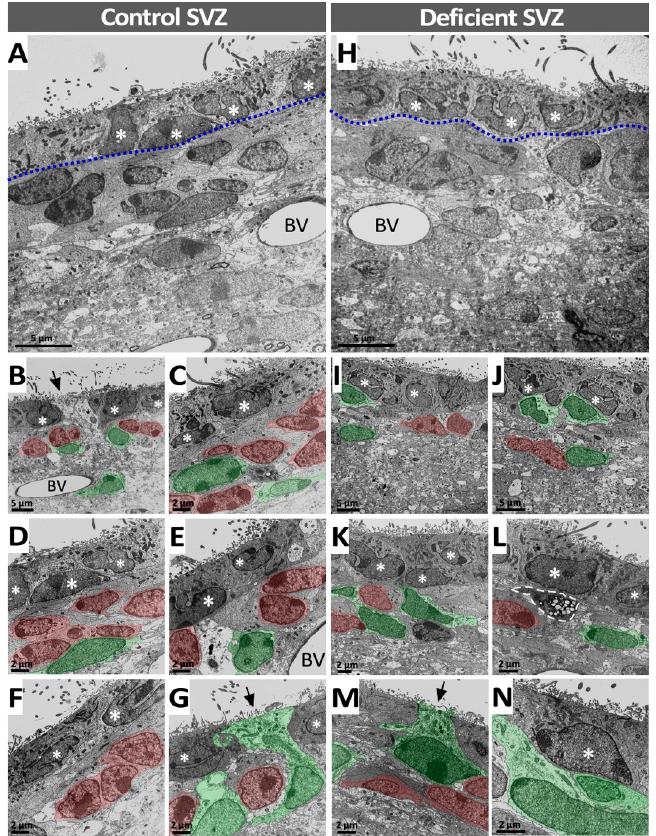
Figure 7. Ultrastructural analysis of the SVZ in vitamin-C-deficient guinea pigs. ( A – G ) Ultrathin sections of the SVZ in control guinea pigs; the ciliated ependymal cell line (dotted line) and different cell types in the subependymal area are observed ( A ). The ependymal cells (white asterisks) show cilia and apical microvilli, an irregular nucleus and an electron-dense cytoplasm ( B – G ). In the subependymal zone, neuroblasts (in red) have a heterochromatic nucleus and a scanty, electron-dense cytoplasm ( B – G ). Astrocytes (in green) have a euchromatic nucleus, an electron-lucent cytoplasm and often contact the ventricle ( G , arrow). C-type cells are not detected in this set of images. ( H – N ) Ultrathin sections of the SVZ of vitamin-C-deficient guinea pigs showed that the cell distribution was similar to control SVZ; however, the number of cells was altered. A decline in the number of neuroblasts was observed and, consequently, cells in the subependymal area were mainly astrocytes ( I – N ). In addition, fewer astrocytes were observed contacting the ventricle ( M , arrow). Apoptotic cell (dashed line) ( L ). LV: lateral ventricle. BV: blood